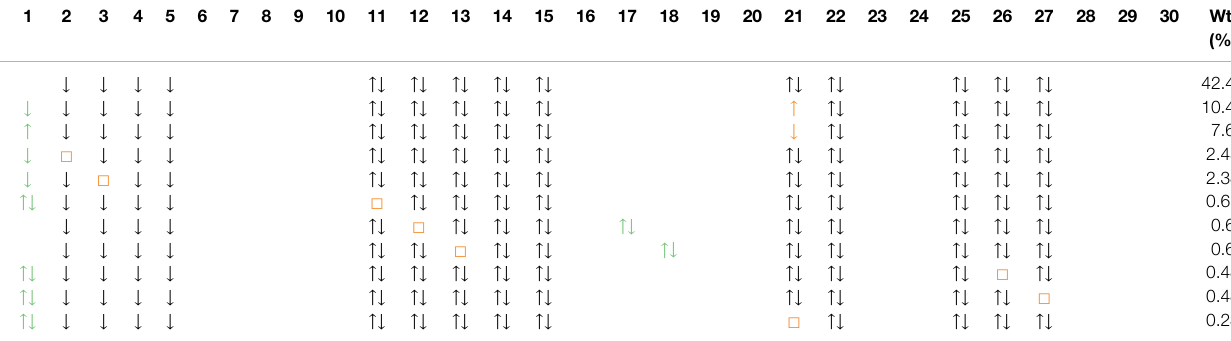
TABLE4| DominanttenSlaterderterminantsandtheirweights(in%)inthe d 8 wavefunctionforNdNiO 2 (wealsoshowthe11thwhichisthesameasthefourthcon fi guration in Table 3 ). The wavefunction is represented in the same basis as the wavefunction in Table 3 . However, for convenience we use the orbital numbers from Figure 2 in the fi rstrowtoexpressthebasis.Theseorbitalsarevisuallyveryclosetotheactualbasis.Thedoublyoccupiedorbitalsareshownas ↑↓ ,thesinglyoccupiedoneswith ↑ ( ↓ )for spin 1 ( − 1 ) and an empty box implies that the orbital is unoccupied. The red (electrons removed) and green (electrons added) colors indicate the orbitals involved in the 2 2 excitation starting from the fi rst con fi guration. The red box indicates that the orbital becomes empty in this particular excited con fi